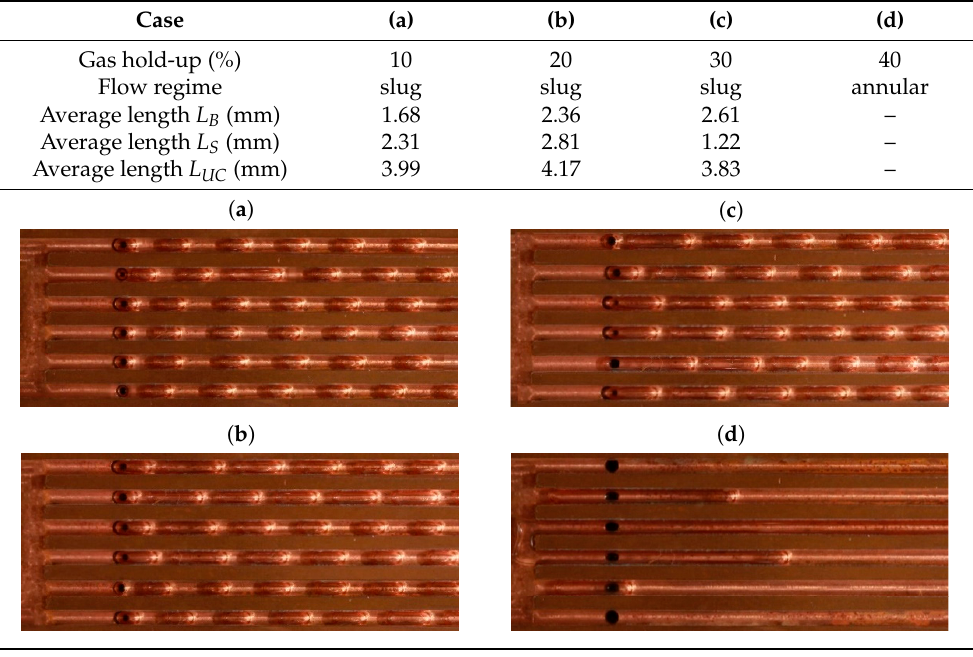
Figure 12. Friction factor for single phase and two-phase flow versus Reynolds number. The segmented flow heat transfer enhancement scheme presented here will only be of interest if it achieves a higher Nusselt number than single phase flow at the same pressure drop and, hence, energy cost. This is confirmed in Figure 13 for pressure drop values ranging from 1 kPa onwards, where the increase in Nusselt number is about 43% using segmented flow instead of single-phase flow, at the same pressure drop.